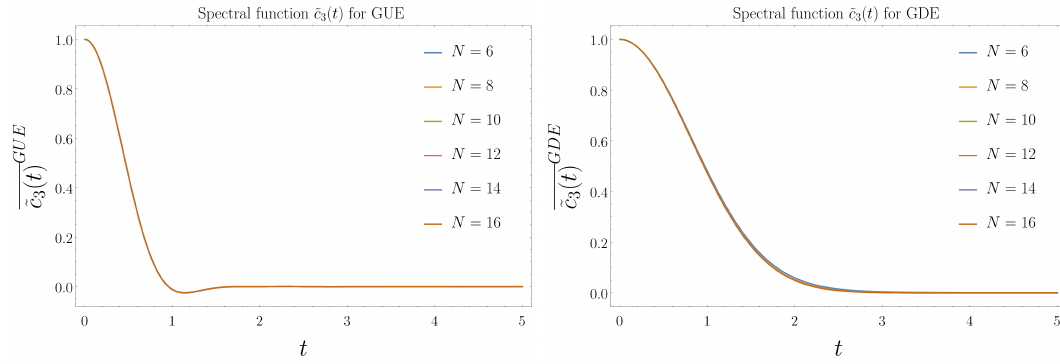
( t ) GUE = Re c ( t ) / d 3 averaged over the 3 3 ( t ) = c ( t ) / d 3 averaged over the GDE ensemble for 3 3